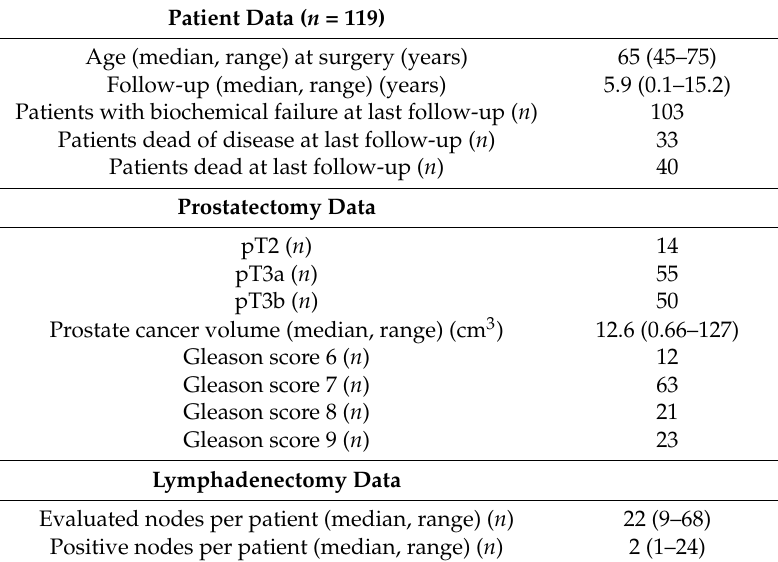
Table 1. Characteristics of 119 nodal positive prostate cancer